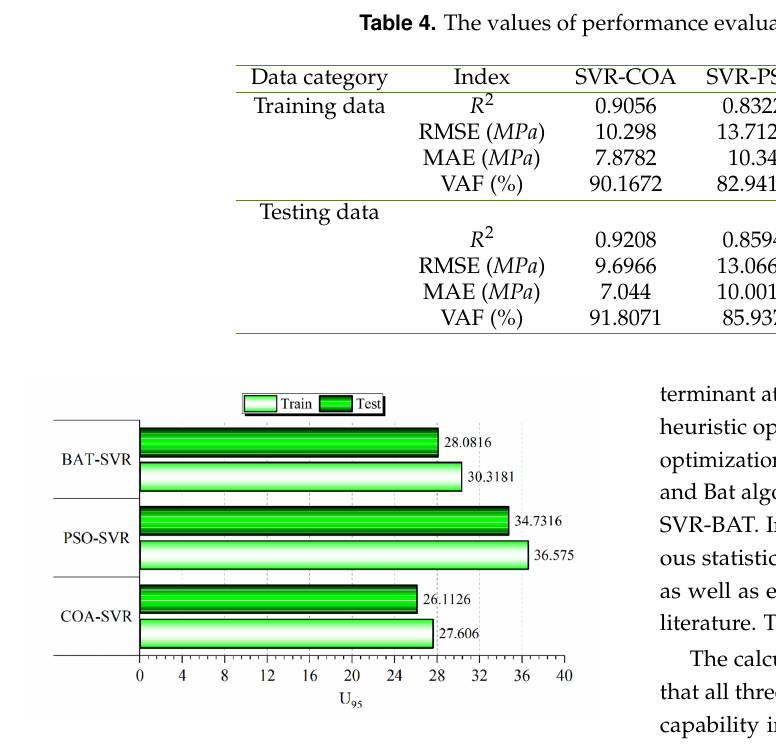
Fig. 6. The results of uncertainty